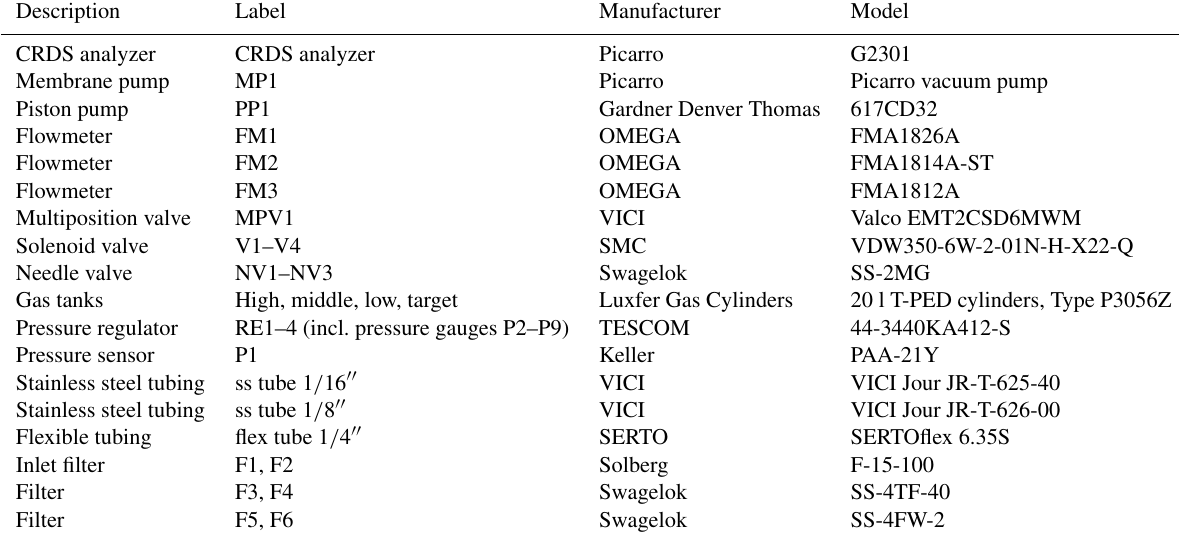
Table A1. Gas handling components.